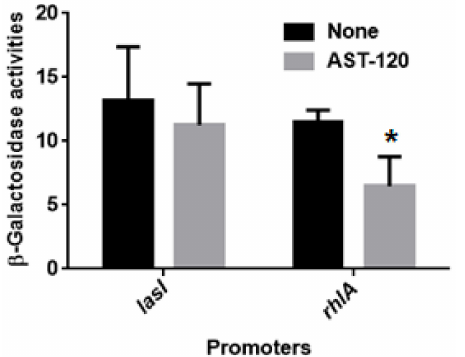
Figure 3. Activities of LasI-LasR and RhlI-RhlR quorum sensing. β -Galactosidase activities of PAO1 containing pBBRlasI (PAO1)-P or pBBRrhlA (PAO1)-P, the lacZ reporter plasmid grown with or without 30 mg AST-120, were measured to determine promoter levels of lasI and rhlI genes regulated by the LasI-LasR and RhlI-RhlR systems. Data plotted are the means from three independent experiments; error bars indicate the standard deviations. Asterisks denote significance for values ( p < 0.05) of promoter activities in PAO1 grown with AST-120 relative to those in PAO1 grown without